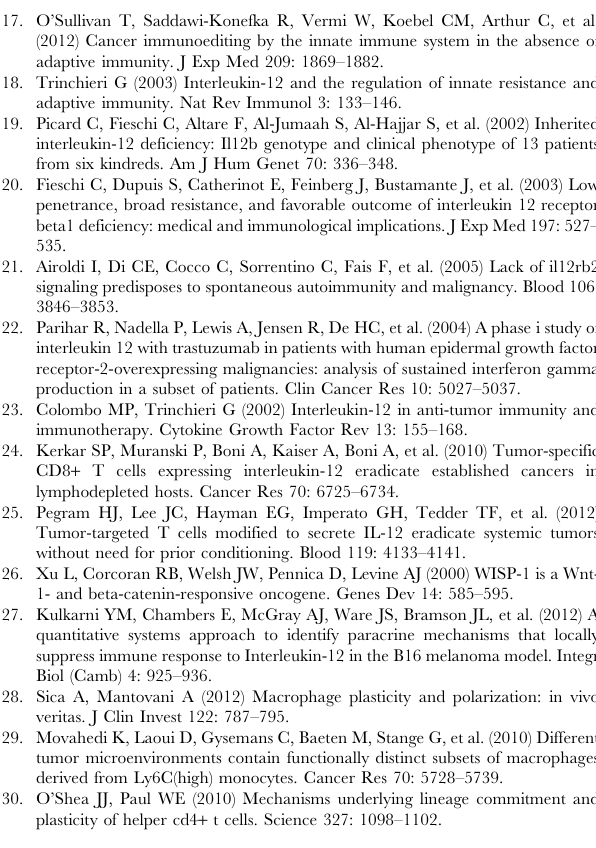
Table S1 Results for Cox proportional hazards regres- sion model. The Cox model: (Survival , p(Th1 T cell) + Mole- cular Pathology). The results suggest that the posterior estimate of a Th1 immune cell polarization gene expression signature (i.e., p(Th1 T cell)) is a predictor of overall survival independent of the molecular pathology. We also found that the other T helper cell polarization states (i.e., p(Th2 T cell), p(Th17 T cell), and p(iTreg T cell)) were not predictive. (PDF) Text S1 TextS1.pdf. This PDF file contains: 1. Principal component analysis 2. External validation of the TCGA